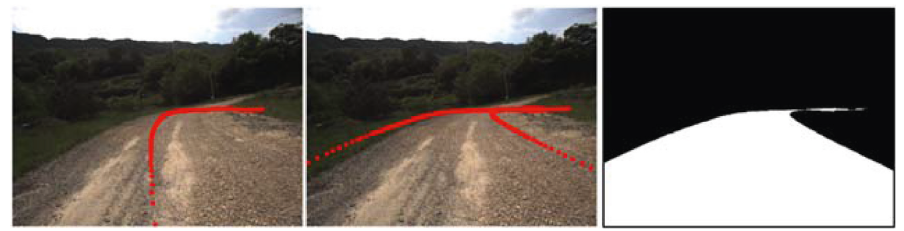
Figure 3: Segmentation labeling process using GNSS/INS data. The left image shows the location points projected on the corresponding image. The center image shows the lateral points of each location. The right image shows a segmentation label constructed from those lateral points.